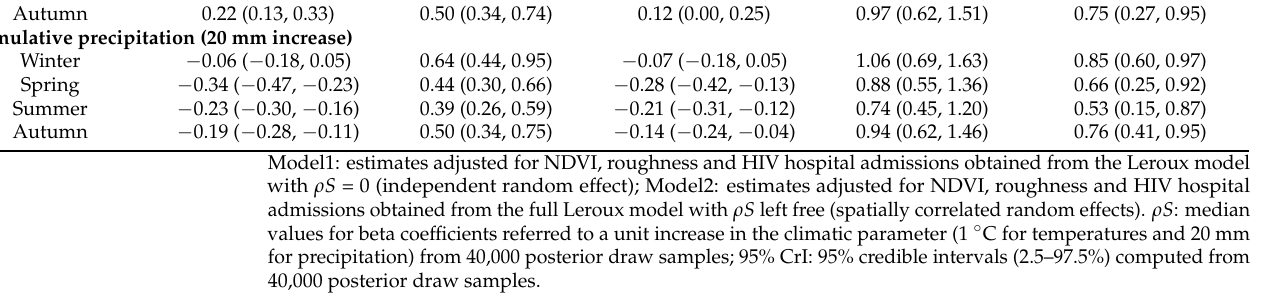
Table 2. Regression coefficients from the spatio-temporal models describing the association between yearly VL incidence, yearly meteo-climatic anomalies over the 2009–2016 period. Season-Year Anomaly Spatial Random Effect Temporal Random Effect